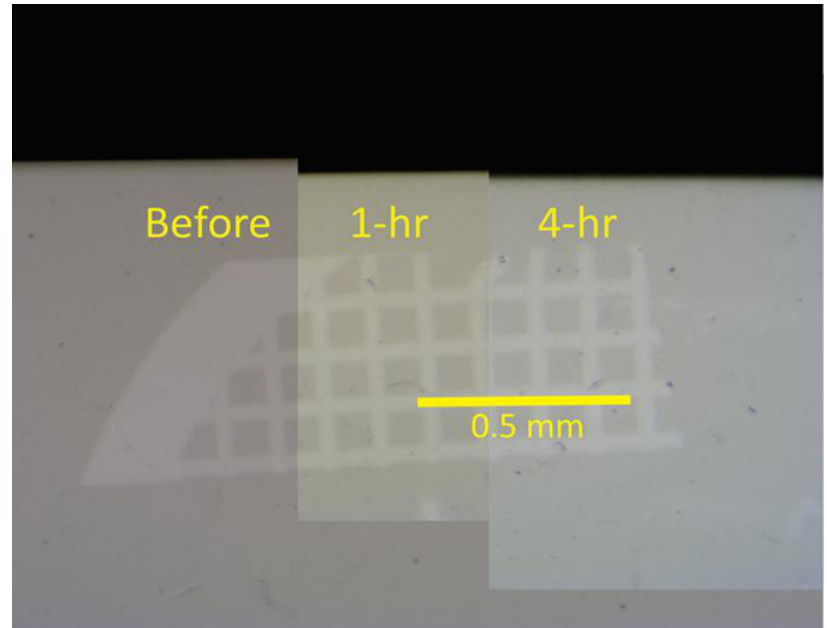
Figure 2. X-ray images aligned to show effect of time on citric acid erosion of dentin. Dentin sample X-rays taken before, and at 1 h and 4 h were aligned using the fiduciary TEM grid marker to assess surface mineral loss.